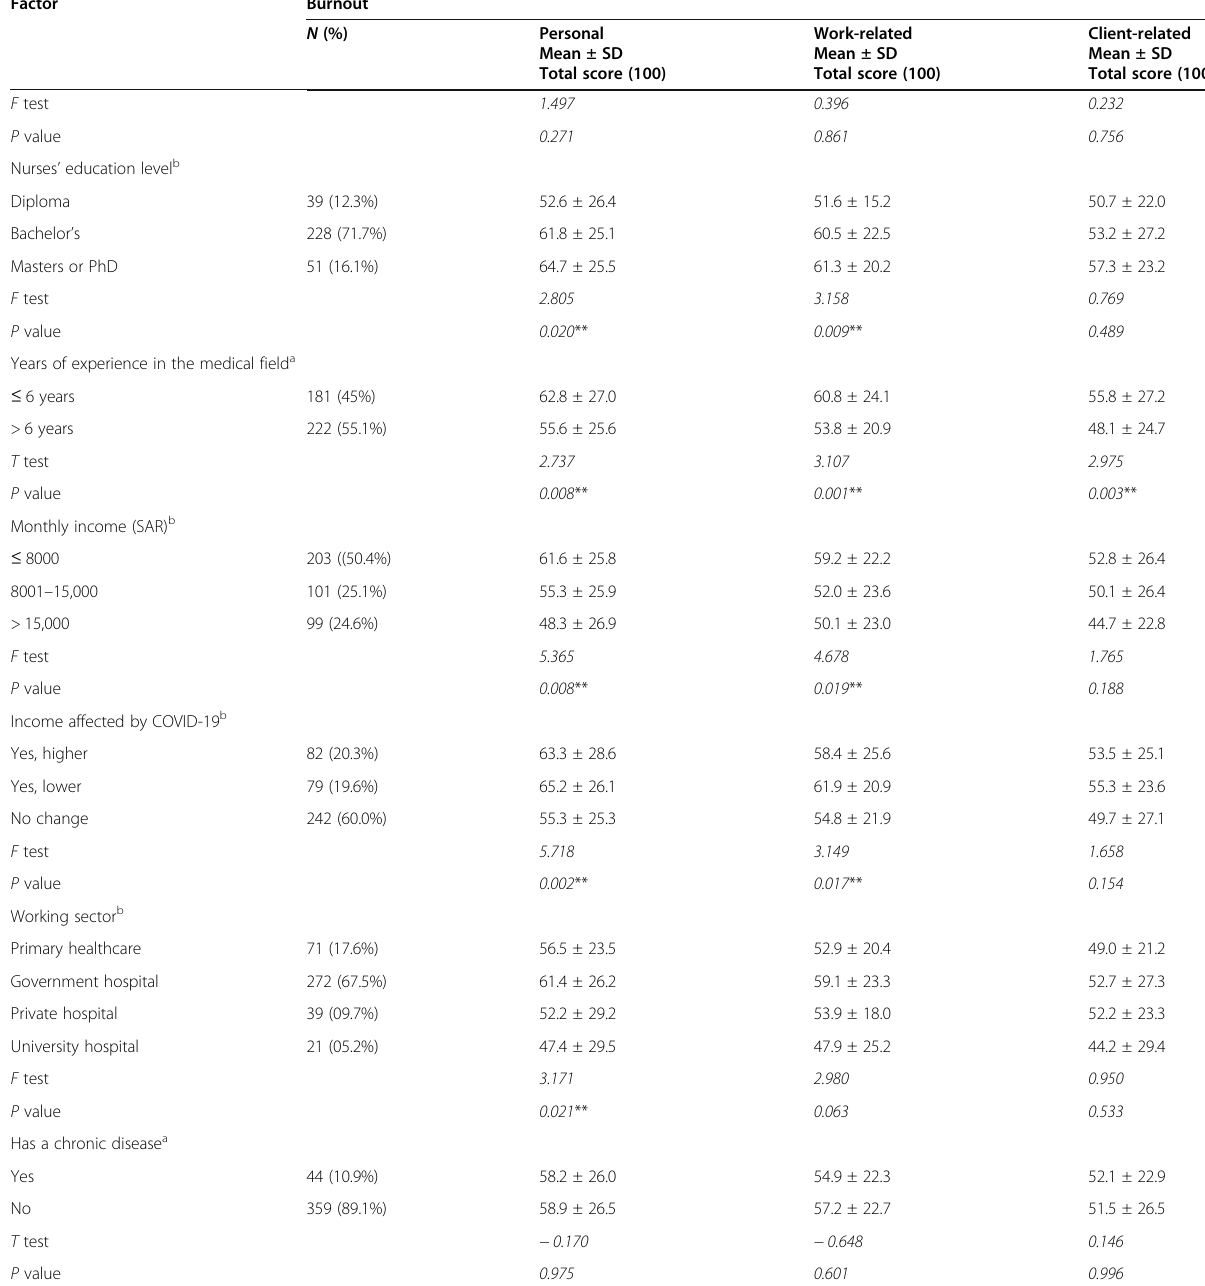
Table 3 Respondents ’ sociodemographic characteristics ( n = 403) and statistical associations between the CBI subscales